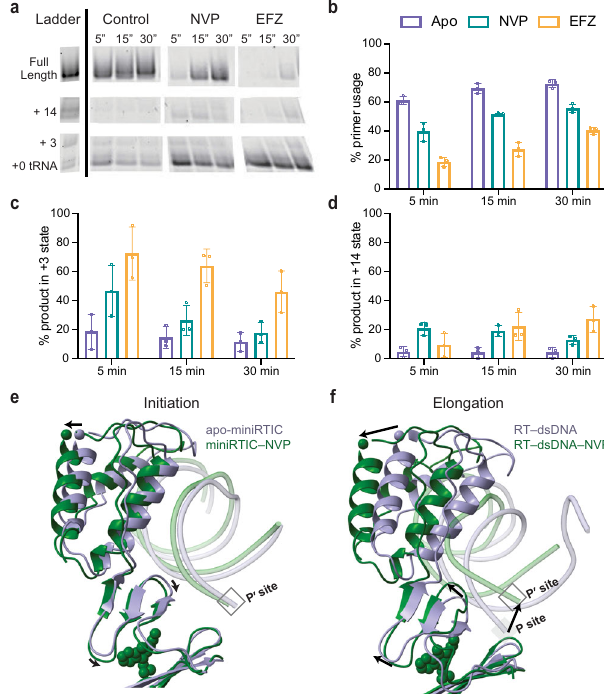
Fig. 5 NNRTIs exacerbate RT pausing during initiation. a Representative sequencing gel of results from reverse transcription assays performed with and without NNRTIs. Identi fi ed and labeled bands of + 0 tRNA, + 3, + 14, and full-length transcripts. Gels are representative of n = 3 independent replicates. b Addition of EFZ or NVP decreases the primer usage at all time points (apo- miniRTIC = purple, miniRTIC – EFZ = yellow, and miniRTIC – NVP = green). c The + 3 pause is exacerbated by both NVP and to a greater extent by EFZ.